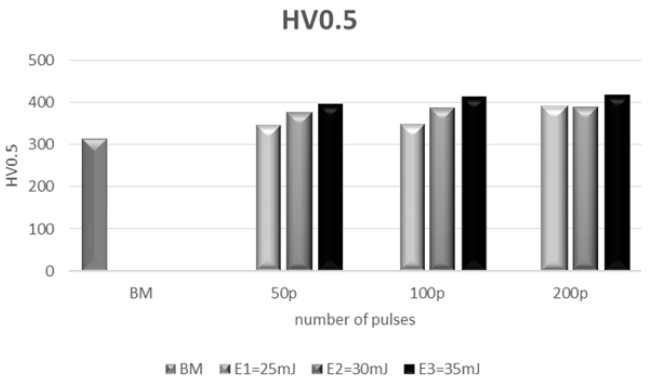
Figure 12. The microhardness measurements of LSP processed areas by laser energies: E 1 = 25 mJ, E 2 = 30 mJ and E 3 = 35 mJ, at wavelength 532 nm.